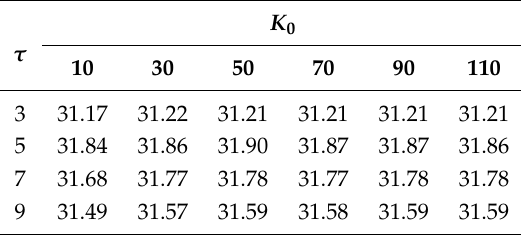
Table 1. Average PSNR (Peak Signal-to-noise Ratio) of Test Images with Different Parameters (Scale Factor = 3, Noise = 0).